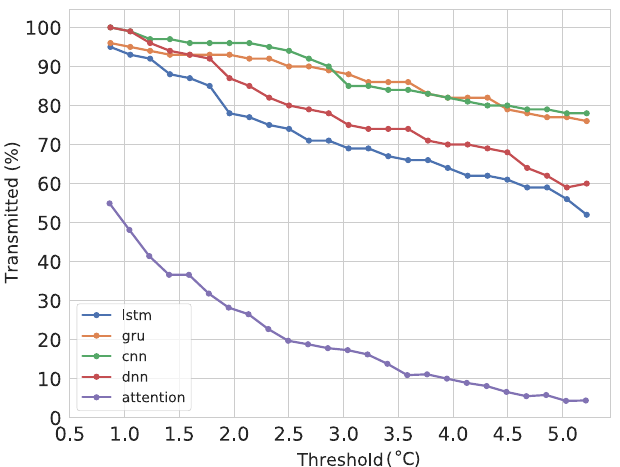
Figure 17. Percent of points transmitted per threshold for the models used for